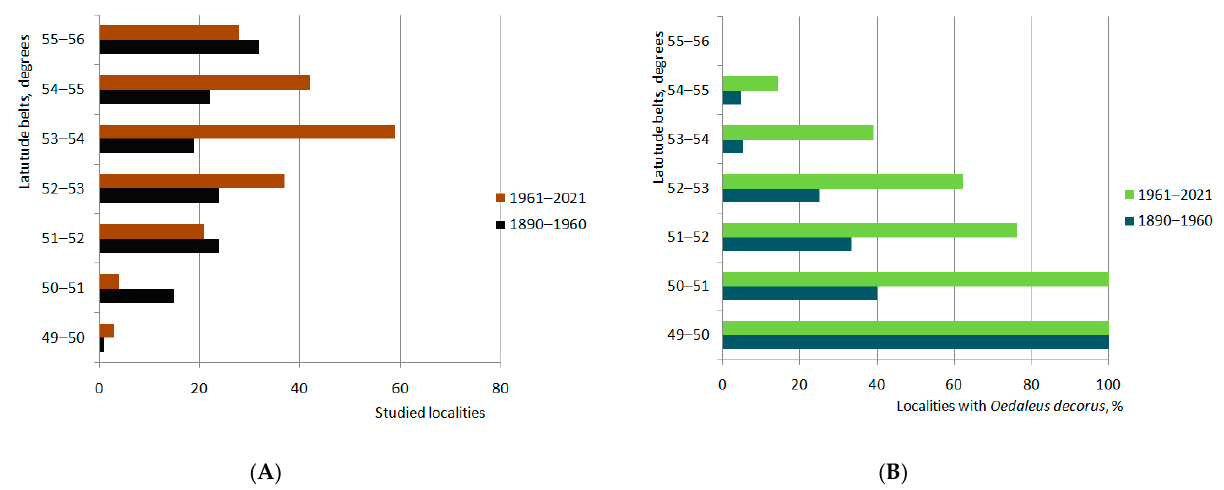
Figure 2. Latitudinal distribution of all studied localities ( A ) and the localities with Oedaleus decorus ( B ) over the south-eastern part of West Siberian Plain until 1960 and after 1961 (Tables S1 and S2).